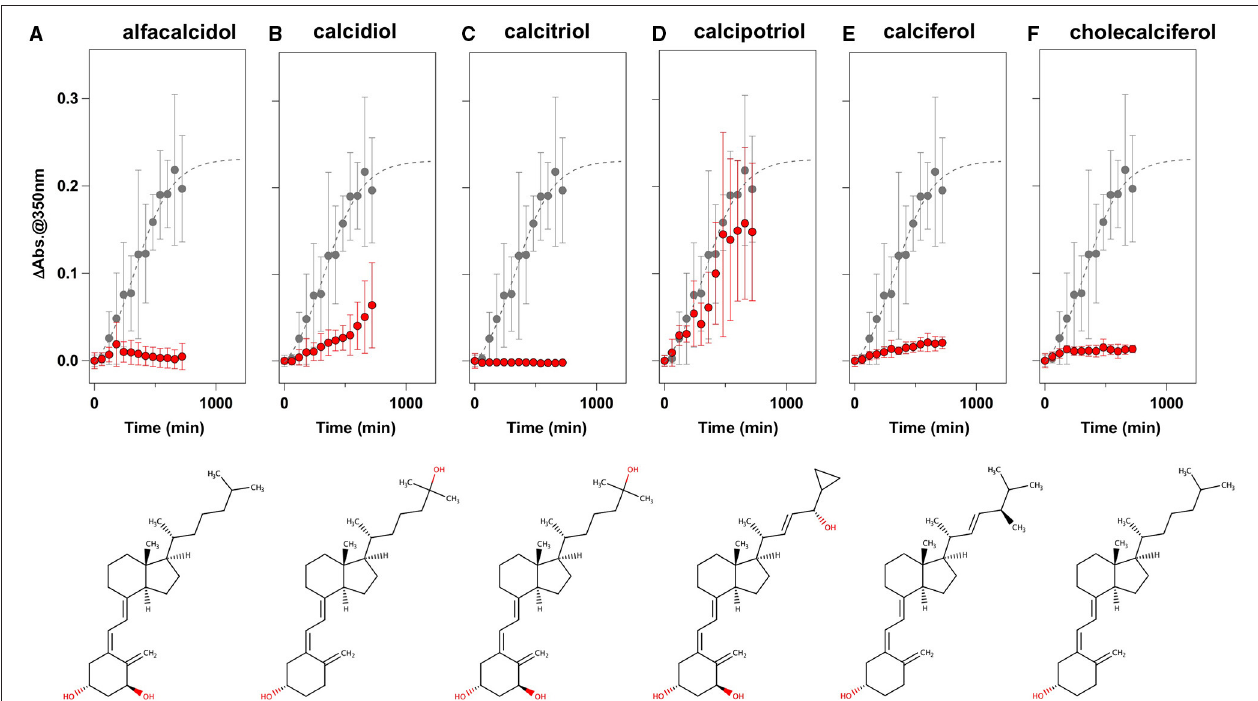
FIGURE 3 | Vitamin D derivatives as potent inhibitors for the formation of insoluble apo-SOD1(G37R) S-S aggregates. (A–F) The turbidity increase of 20 µ M apo-SOD1(G37R) S - S in the presence of 1MGdn is shown in the presence of the following compounds (red filled circles): (A) alfacalcidol, (B) calcidol, (C) calcitriol, (D) calcipotriol, (E) calciferol, and (F) cholecalciferol. In each panel, the aggregation kinetics without any drugs was shown as gray filled circles. The kinetics was monitored by changes in the solution turbidity (the absorbance at 350nm), and the final concentration of drugs added was 20 µ g/mL. Experiments were repeated more than three times to estimate error bars (standard deviation). Structures of the chemical compounds were also shown below the